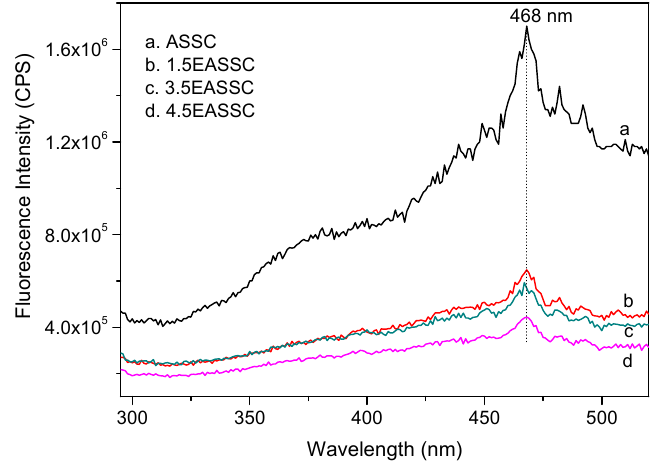
Figure 5. Photoluminescence spectra of samples (excitation wavelength of 280 nm).